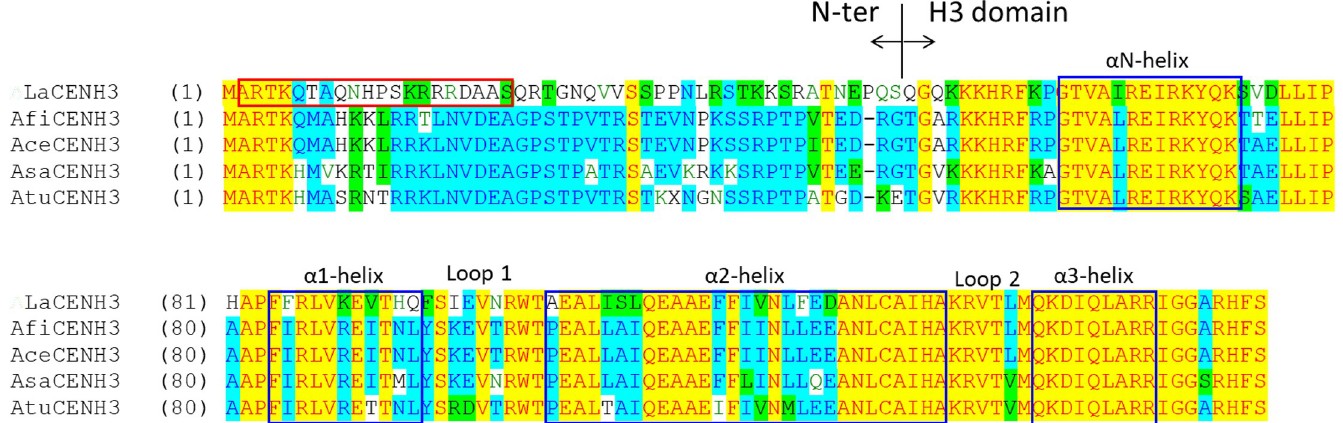
Fig 4. Multiple amino acid sequence alignment of CENH3s of Lycoris aurea (LaCENH3) and Allium species including A . fistulosum (AfiCENH3), A . cepa (AceCENH3), A . sativum (AsaCENH3), and A . tuberosum (AtuCENH3). Identical amino acids are indicated by the same colors. The left side of the vertical bar is the N-terminal region (N-ter) and the right side is the histone fold domain (H3 domain). The N-terminal is less conserved as compared with the H3 domain. Six functional domains are indicated in blue boxes. The sequence of peptide used to produce the anti-CENH3 antibody is indicated in the red box. https://doi.org/10.1371/journal.pone.0258028.g004 proteins with the anti-LaCENH3 antibody (S1 Fig). Cytological immunostaining with anti- LaCENH3 antibody presented strong signals in the interphase nucleus (Fig 5) and indicated the centromere positions of mitotic chromosomes of both L . aurea and L . radiata (Figs 6 and 7). The immuno-signals on the interphase nucleus appeared as spots of various size and inten- sity, which indicated different abundance of LaCENH3 protein at individual centromeres (Fig 5). The number of signals differed among nuclei because some centromeres embedded within